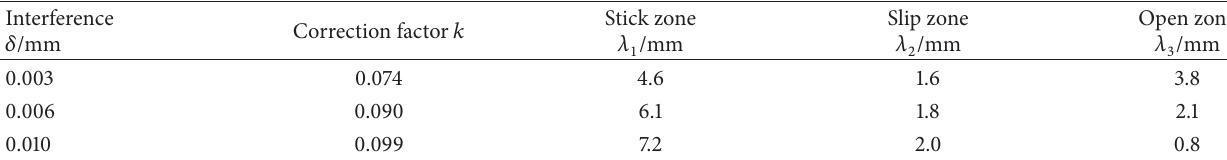
Table 2: Sizes of three zones under different